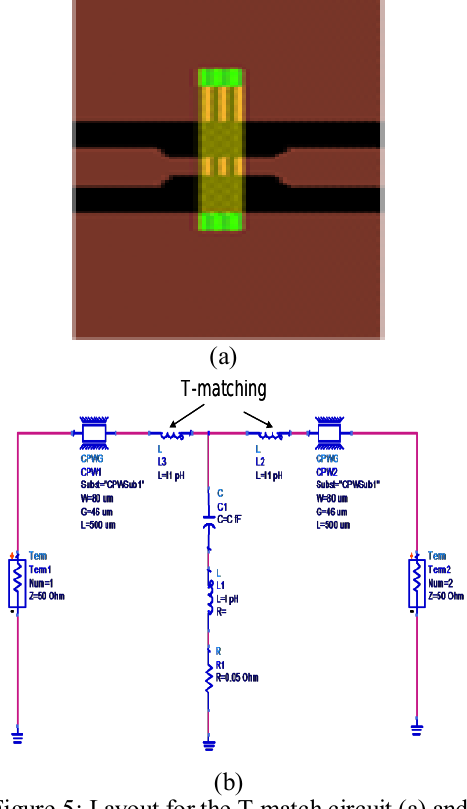
Figure 5: Layout for the T-match circuit (a) and equivalent circuit (b).